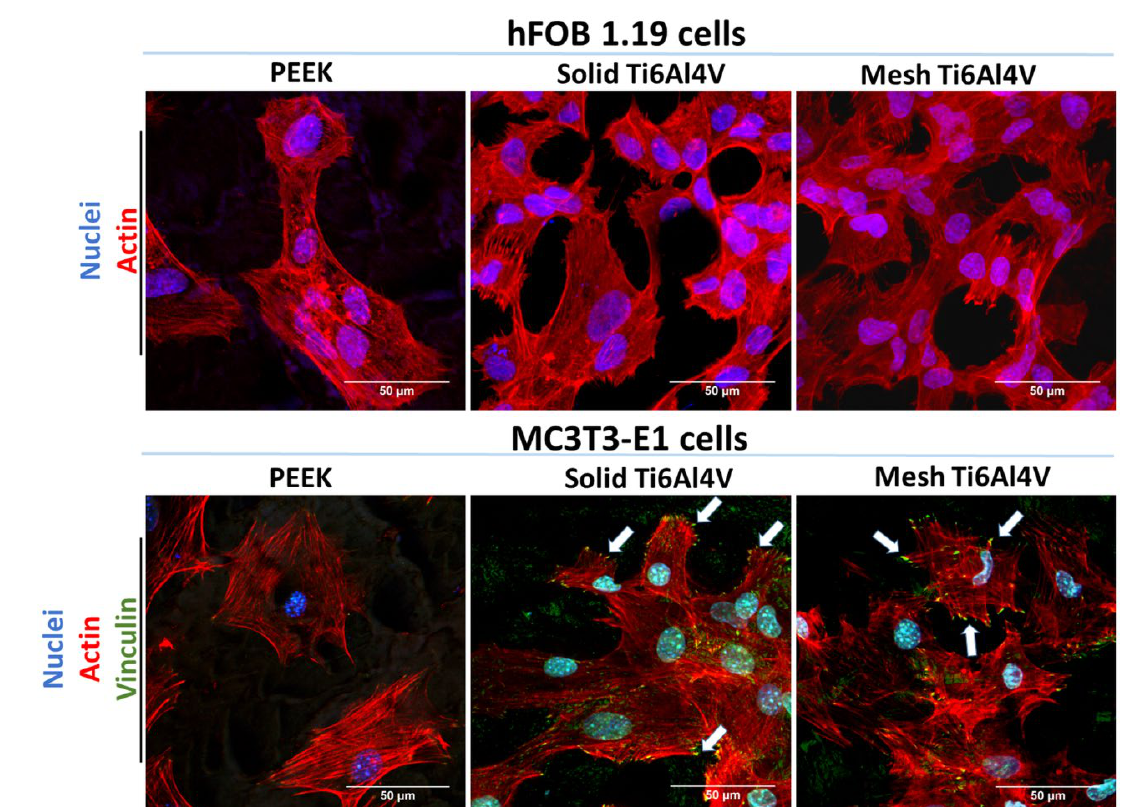
Figure 6. CLSM images showing osteoblasts’ morphology and adhesion after 48-h culture on the tested samples; hFOB 1.19 cells: red fluorescence—F-actin, blue fluorescence—nuclei; MC3T3-E1 cells: green fluorescence—vinculin, red fluorescence—F-actin, blue fluorescence—nuclei (white arrows indicate FAPs visible as green dot-like structures on the edges of the cells); magnification 400× + 2f, scale bar = 50 μm.